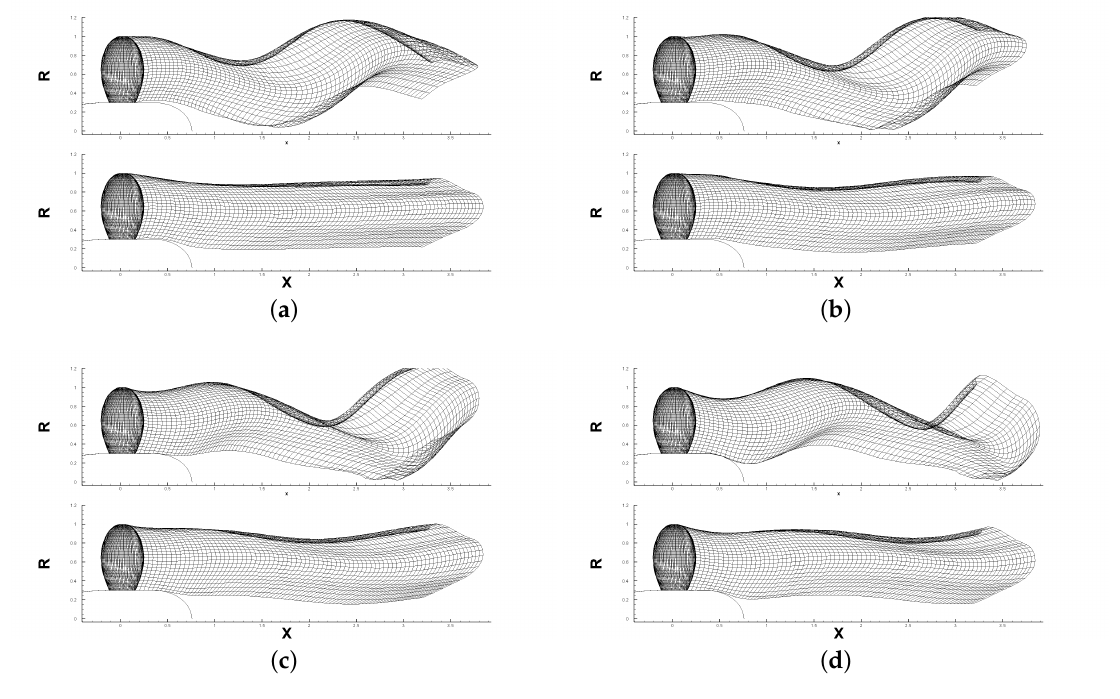
Figure 11. Projected view of the fully aligned wake ( up ) and its initial geometry ( down ), plotted on the X − R plane at the blade angle of ( a ) θ = 0 ◦ , ( b ) 72 ◦ , ( c ) 144 ◦ , and ( d ) 216 ◦ . Propeller forces ( KT and 10 KQ ), predicted by the hydrodynamic BEM, are compared with the RANS results at four different advance ratios, i.e., 0.8, 1.0, 1.2, and 1.4, in Figure 13. Overall, the two methods seem to agree well with each other, especially around the design J S = 1.14. The forces (torque coefficients and thrust coefficients) from RANS are evaluated with the time step δ t = 0.003 during more than 6 revolutions until the unsteady forces converge. BEM completed 10 wetted revolutions, and the results converged after the 6th revolution. BEM takes several wetted revolutions to fully align the wake due to its gradual alignment process in non-axisymmetric effective